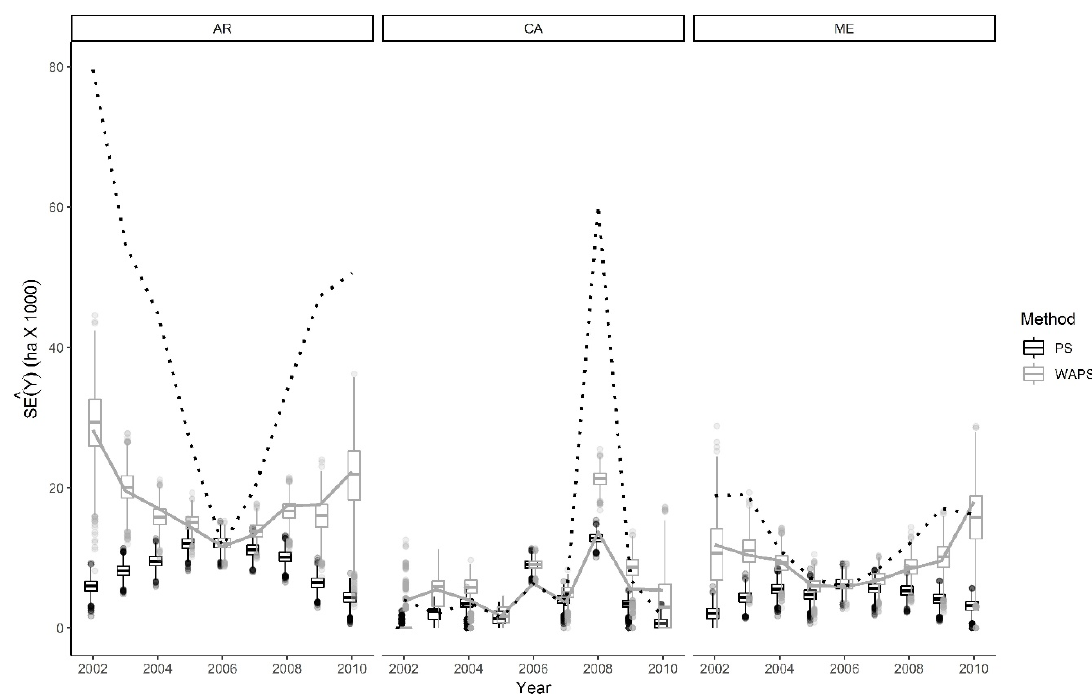
Figure 4. Distribution of the standard error of estimated total (SE( ˆ Y )) for the PS method (black box and whisker plot) and for the WAPS method (gray box and whisker plots) for each disturbance year and population. The dotted black line is the root mean square error (RMSE) from the PS method and the solid grey line is the RMSE from the WAPS method.